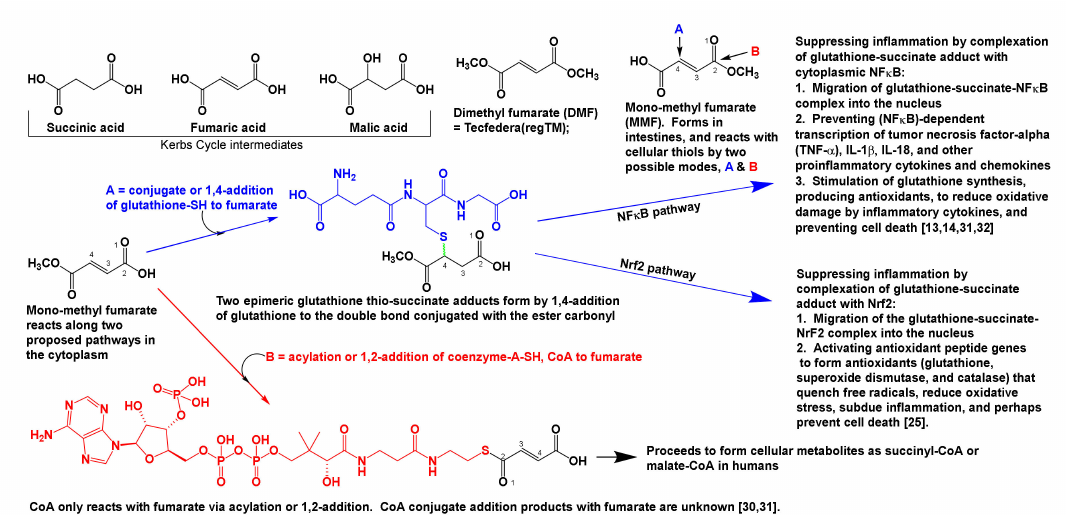
Figure 1. Fumarates and proposed immune modulation mechanisms. Fumaric acid is a Krebs cycle intermediate, wherein, succinic and malic acids are precursor and product, respectively. DMF forms monomethyl fumarate, which crosses the BBB, and is speculated to subdue inflammation by two mechanisms: (1) NF κ B pathway: When glutathione thio-succinate adduct complexes NF κ B, it is expected to block the synthesis of TNF- α and other proinflammatory cytokines and prevents cell apoptosis, and (2) NrF2 pathway: When glutathione thio-succinate adduct complexes NrF2 it suppresses inflammatory cytokine syntheses and stimulates the production of antioxidants (catalase, glutathione, and superoxide dismutase, etc.) which then quench reactive oxygen and nitrogen free radicals and reduce oxidative stress. Prolonged use of DMF causes leukocytopenia. As opposed to wide spread immune suppression, as seen with steroids, immune modulation is considered targeted therapy because it acts on few physiological defenses. Coenzyme-A adds to fumarate by 1,2-addition (acylation, reaction B) and not by conjugate, 1,4-addition (reaction A). The resulting fumarate-, malate-, or succinyl-CoA adducts form normal Krebs cycle metabolites